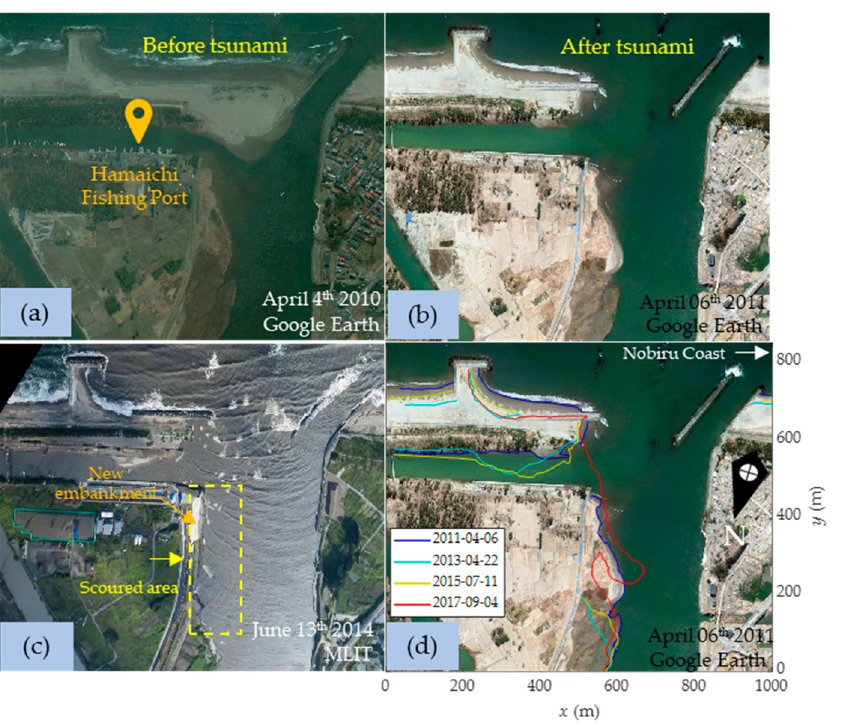
Figure 12. The Naruse River mouth. ( a ) Before the 2011 tsunami. ( b ) Disappearance of sandspit after the tsunami. ( c ) Scour inside the river mouth. ( d ) Sediment deposition inside the river mouth.